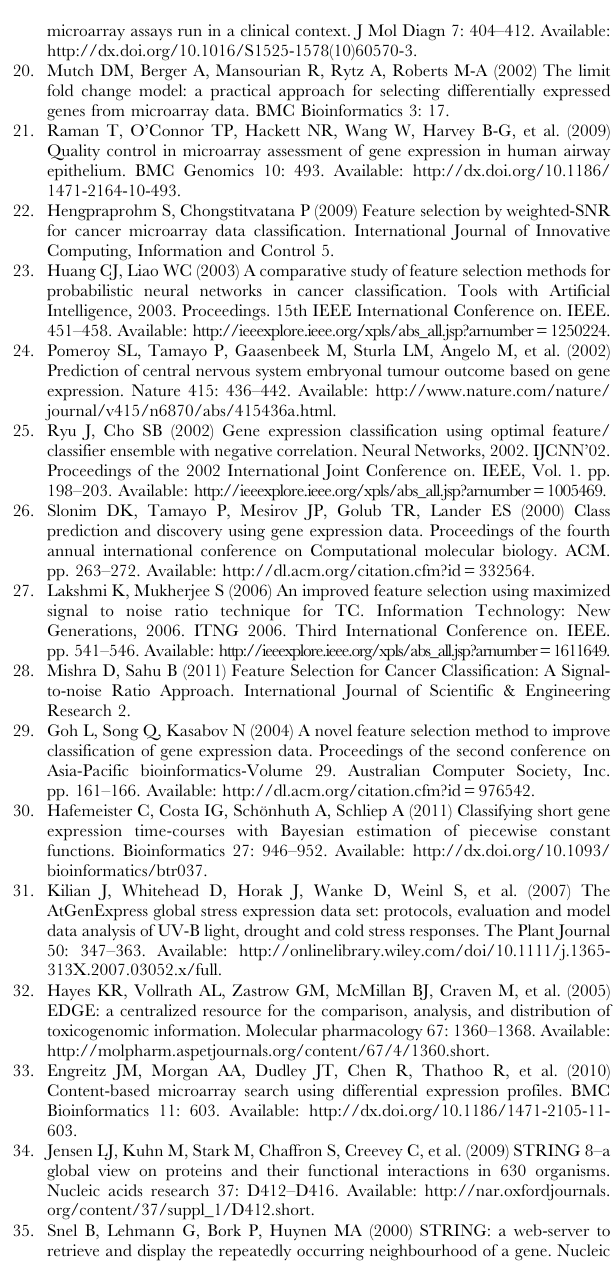
Figure S1 Example of cross-validation when all time points of an experimental condition are selected as test data. (TIF) Text S1 Results of comparison between rSNR and Significance Analysis of Microarray